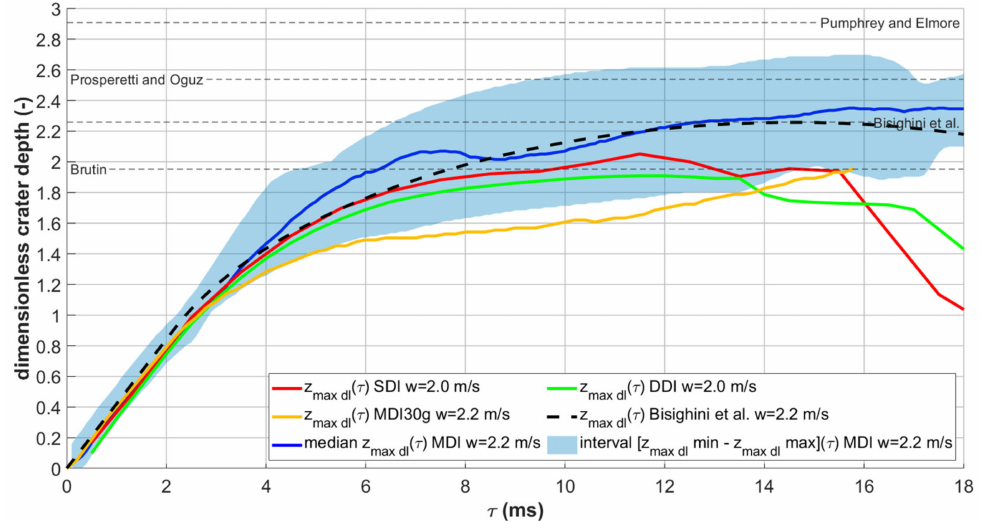
Figure 9. Dimensionless crater depth as a function of time for single, double, and multiple drop impacts at 2.2 m/s. Predictions from some of the most credited literature models are also